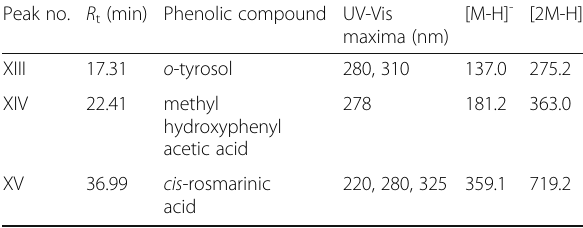
Table 2 Additional compounds identified in Melissa